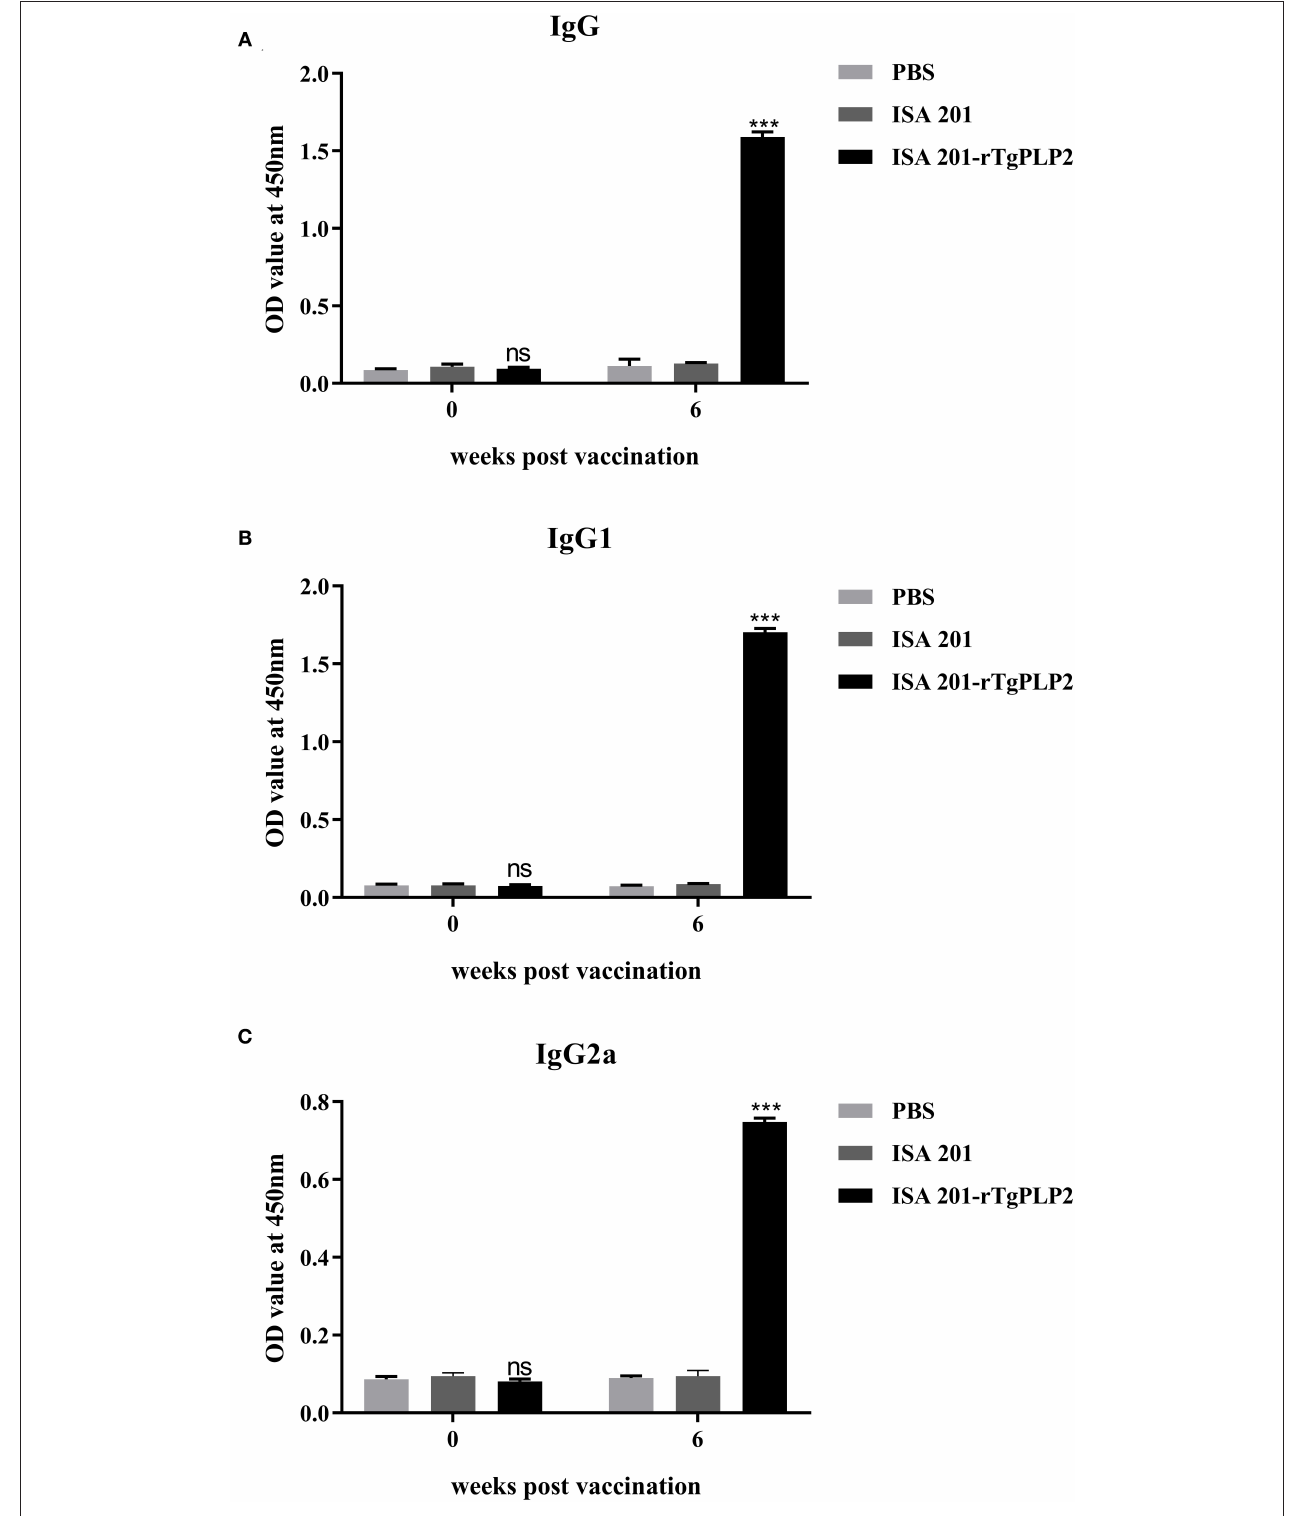
FIGURE 5 | Specific anti-rTgPLP2 antibody responses in mice vaccinated with rTgPLP2. (A) Changes in specific IgG level at weeks 0 and 6 Post-vaccination. (B) Changes in specific IgG1 level at weeks 0 and 6 Post-vaccination. (C) Changes in specific IgG2a level at weeks 0 and 6 Post-vaccination. Data were expressed as mean ± SD for 10 mice per group. *** p < 0.001 and ns (Non-significant) vs. PBS or ISA 201 groups.